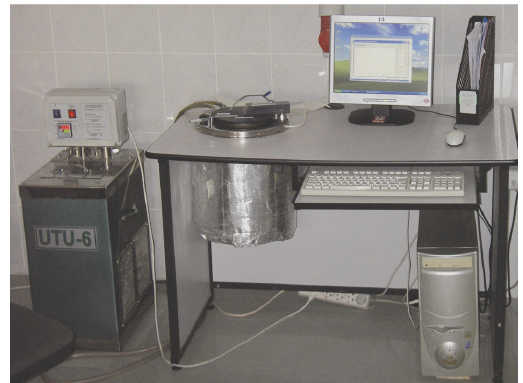
Fig. 7. Testing equipment